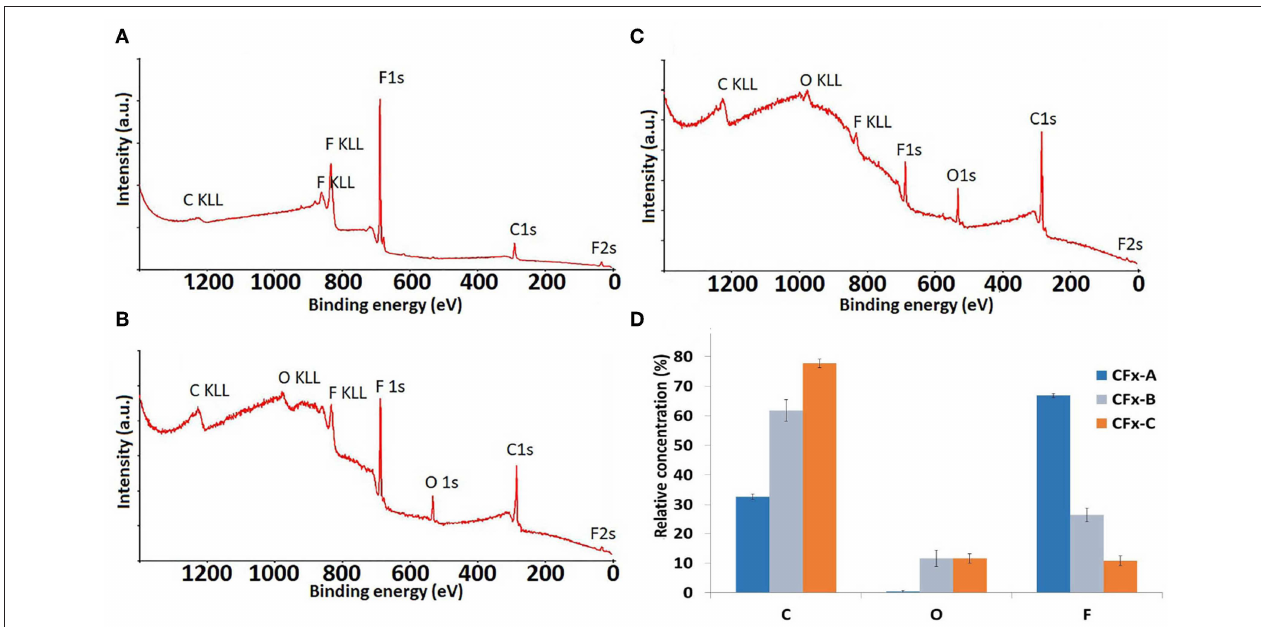
FIGURE 2 | XPS survey spectra of the untreated CF x film (A) and CF x films treated with 30 s (B) and 90 s (C) methanol plasma treatment and histogram of the relative concentration of C, O, and F (D)